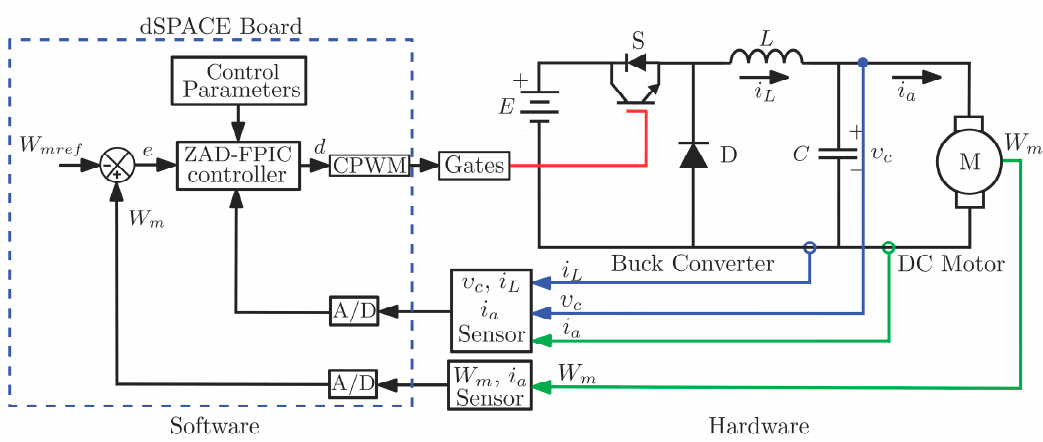
Figure 1. Diagram of the buck converter with zero average dynamics and fixed point induction control (ZAD-FPIC) techniques to control the speed of a direct current (DC) motor. CPWM, centered pulse width modulation.